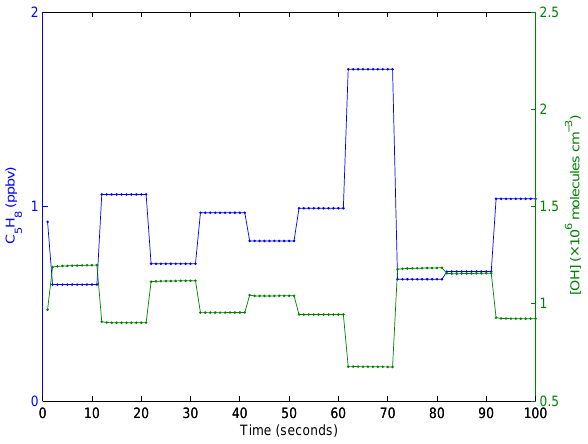
Fig. A1. Response of modelled [OH] to a change in the supplied C 5 H 8 . Each model time-point is marked by a